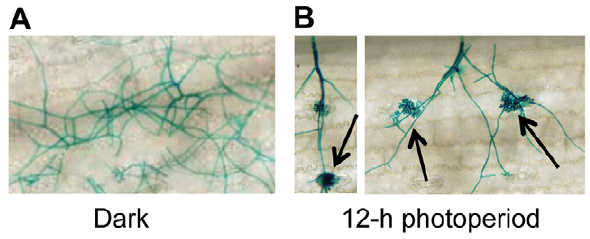
Figure 1. C.zeae-maydis requires light to form appressoria and infect maize. A GUS-labeled reporter strain of C. zeae-maydis was inoculated on maize leaves, and incubated for four days in either A, 12 h light/dark cycles, or B, constant darkness. Black arrows indicate appressoria.